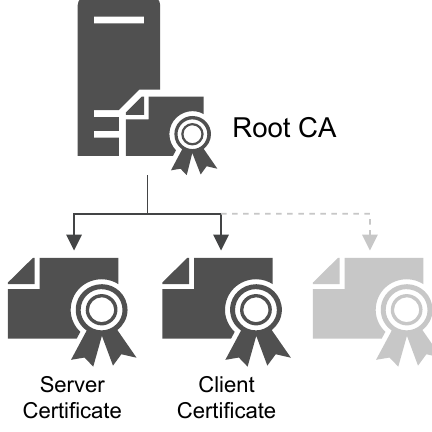
Figure 5. Certificate structure used in this